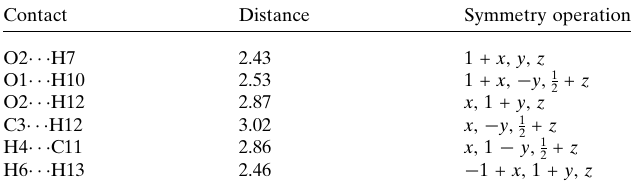
Table 2 Summary of short interatomic contacts (A˚ ) in the title